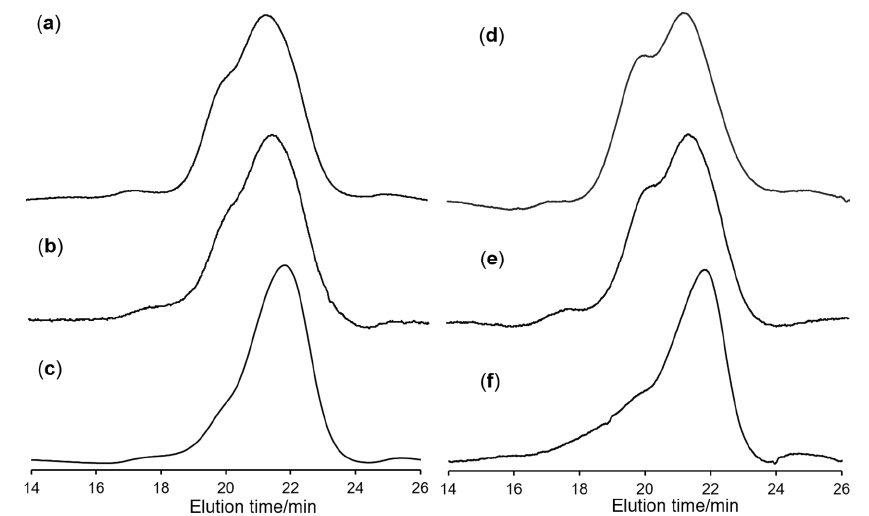
Figure 1. Selected GPC traces in the resultant polymers prepared by Method 2 (shown in Scheme 3, CL/Mo = 15). Reaction time at the second stage (core formation) = 50 min ( a – c ), 70 min ( d – f ). Calculated concentration for NBE + CL = 11.1 × 10 − 2 M (( a ) run 4, ( d ) run 5), 8.67 × 10 − 2 M (( b ) run 11, ( e ) run 12), and 5.20 × 10 − 2 M (( c ) run 16, M n = 1.45 × 10 5 , M w / M n = 1.28; ( f ) run 20, M n = 1.53 × 10 5 , M w / M n = 1.39). Detailed data are shown in Table 1. Table 2. Synthesis of star-shaped polymers by living ring-opening metathesis polymerization (ROMP) using Mo(CHCMe 2 Ph)(N-2,6- i Pr 2 C 6 H 3 )(O t Bu) 2 (Method 2) a .